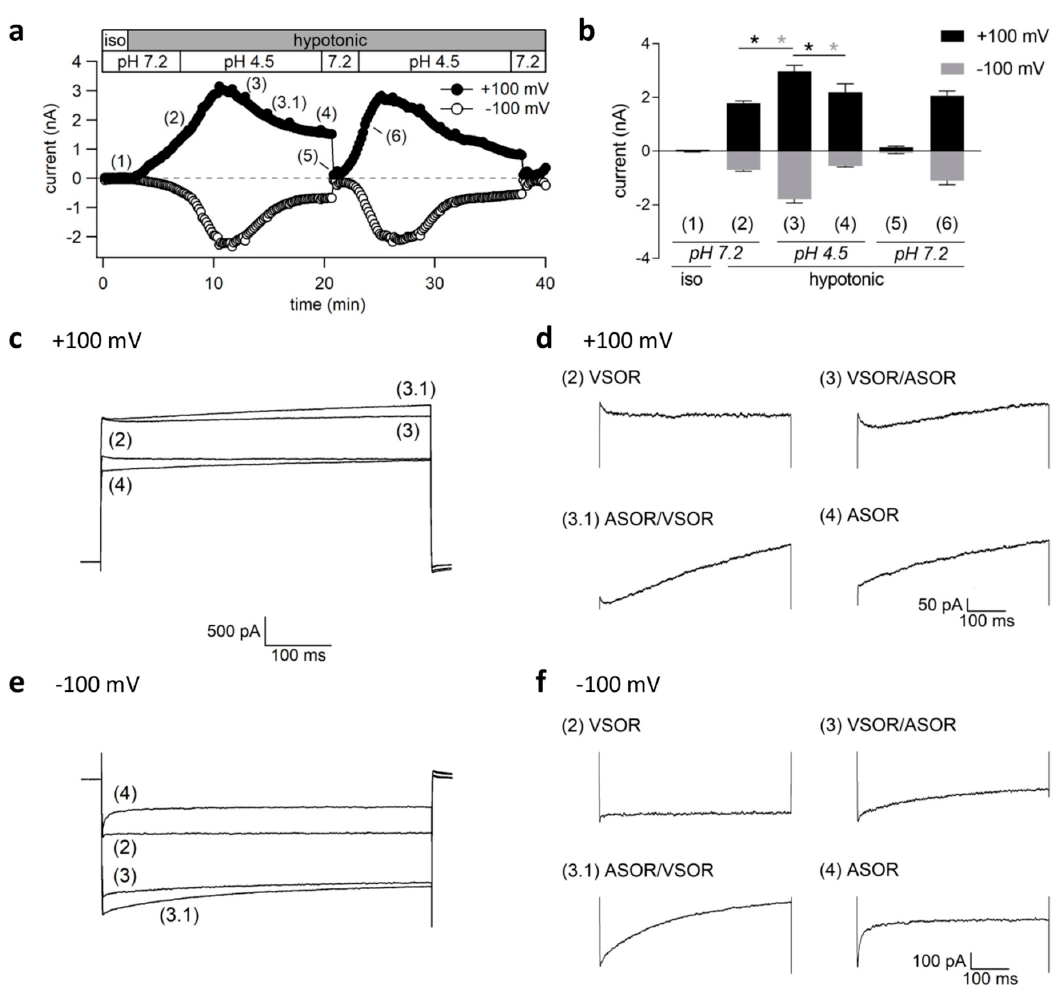
Figure 5d,f are the same as in c and e, except for an extended y -axis spreading to better visualize the current kinetics.